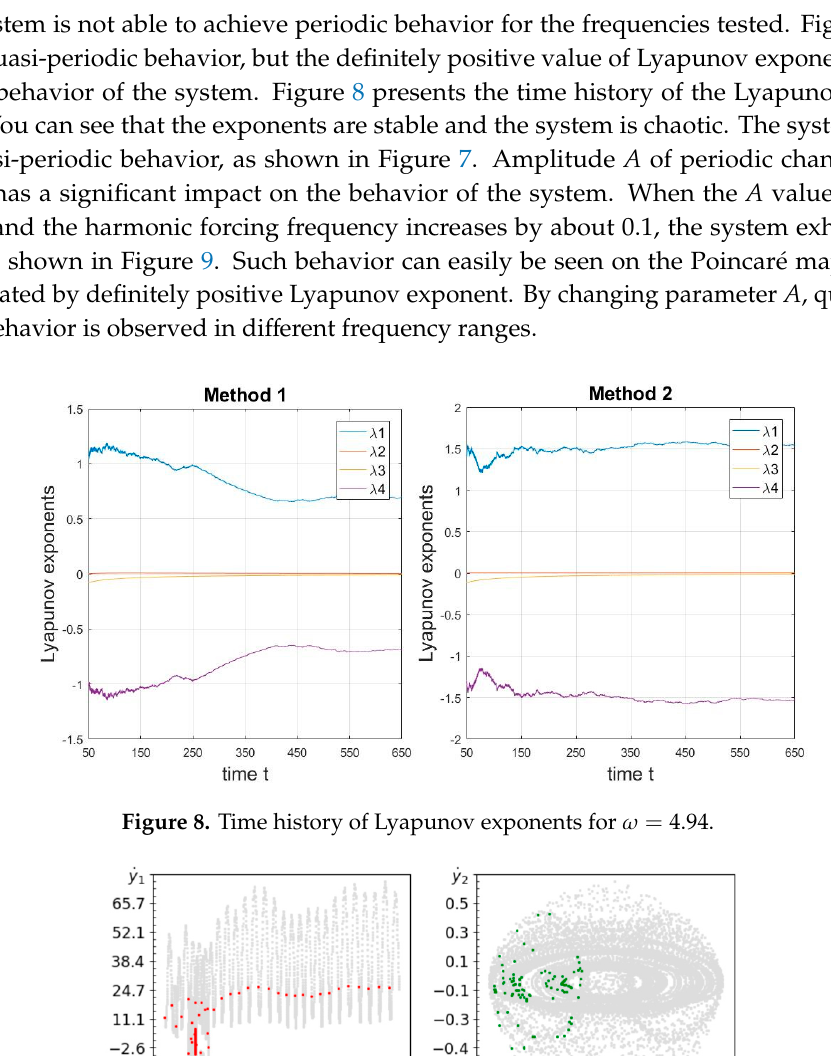
Figure 9. Phase planes (gray lines) and Poincar é maps (red and green dots) for A = 0.15, ω = 5.04 .